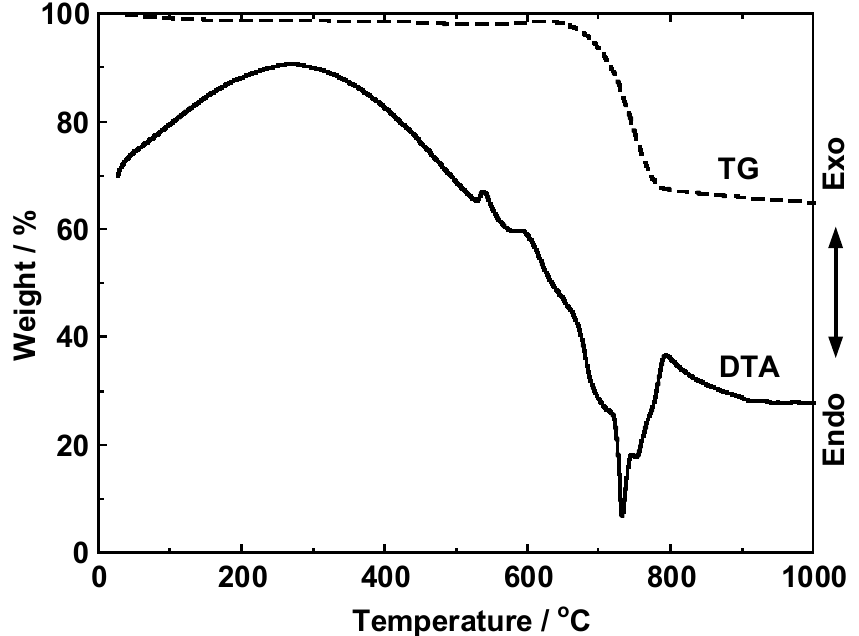
Figure 2. Thermogravimetric (TG) and Differential Thermal Analysis (DTA) curves for the cathode model sample.